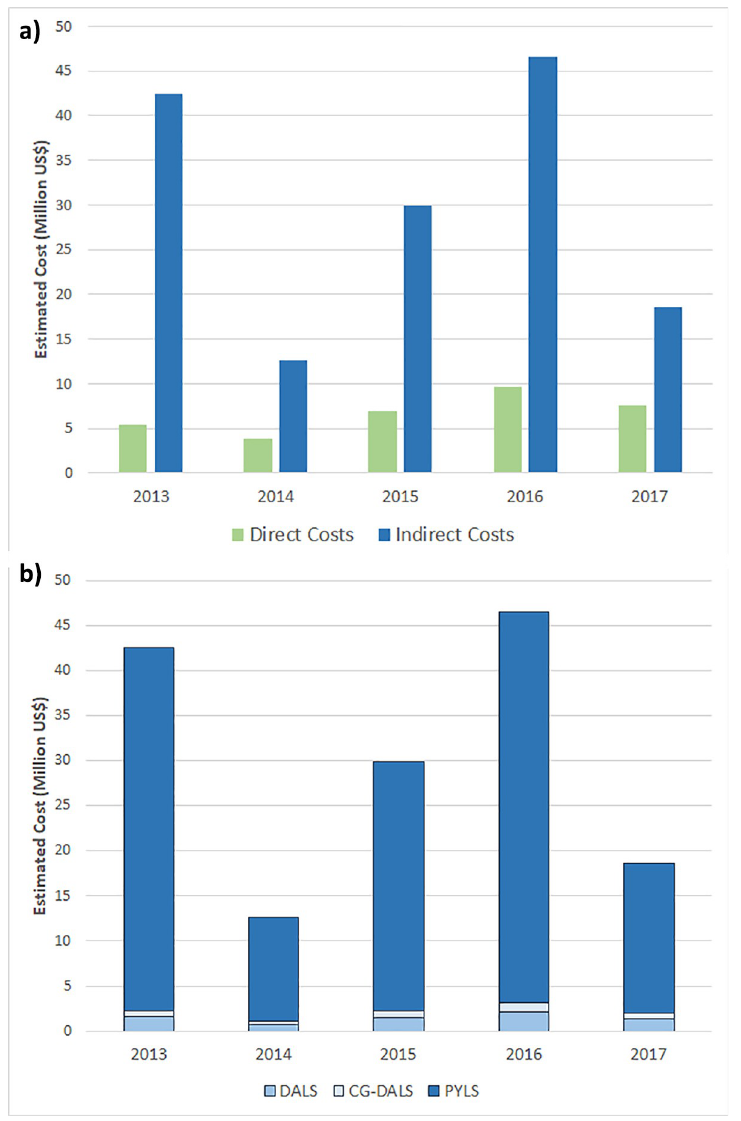
Fig 2. Estimated direct and indirect costs of dengue fever in Saudi Arabia during the period 2013–2017. Bars represent the amount in US$ of the (a) estimated direct and indirect costs by year, and (b) different components of indirect costs including costs related to daily activity loss (DALS), caregiver daily activity loss (CG-DALS) and productivity years loss (PYLS).